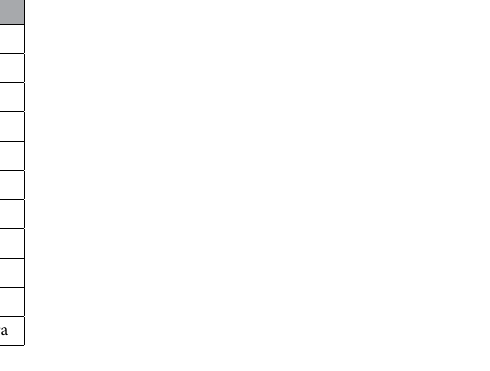
Table 4. Crystal systems of chemical components.